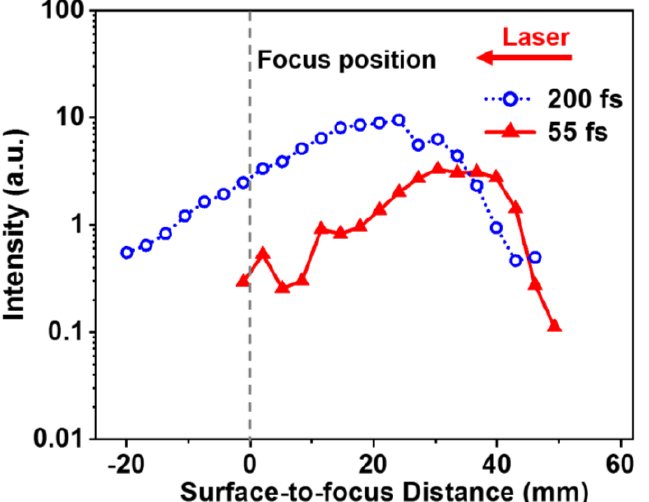
Figure 4. FIBS intensities obtained at different surface-to-focus distances by the excitations of the chirp-free 55 fs (triangle) and negatively chirped 200 fs (circle) pulses. The gray dashed line is the focal position of the lens.